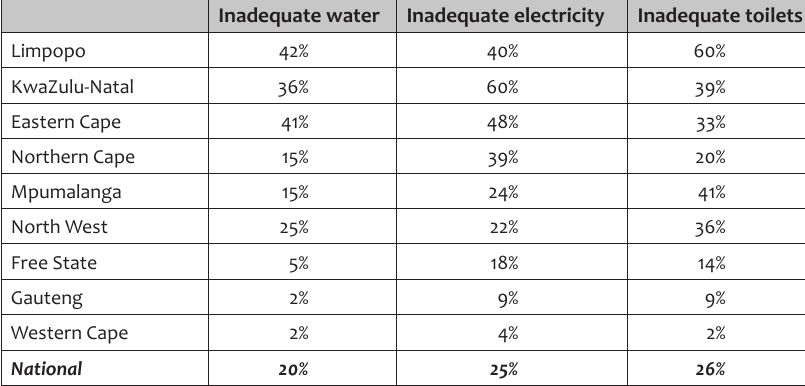
Table 2: Percentage of ECD centres lacking adequate infrastructure, 2013 (Source: RSA DSD 2014)